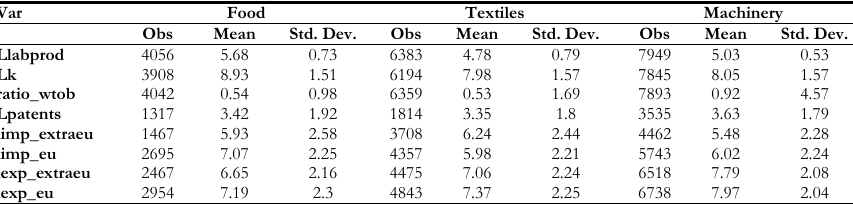
Descriptive Statistics for selected